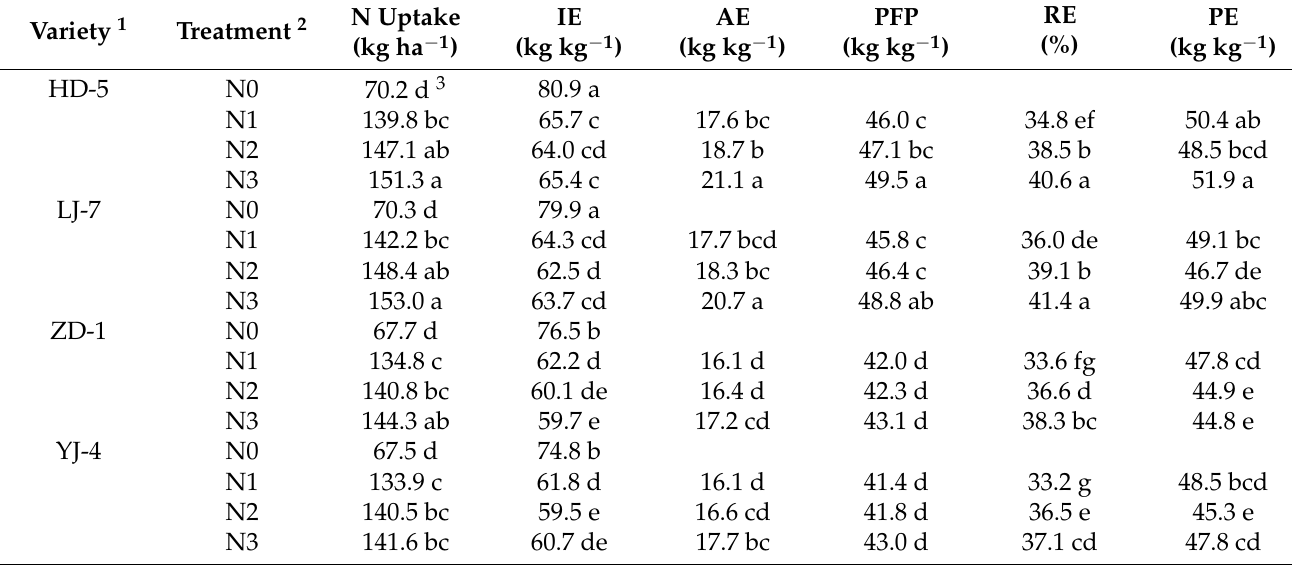
Table 5. Nitrogen (N) uptake and N-use efficiency (NUE) of rice under various N managements. Variety